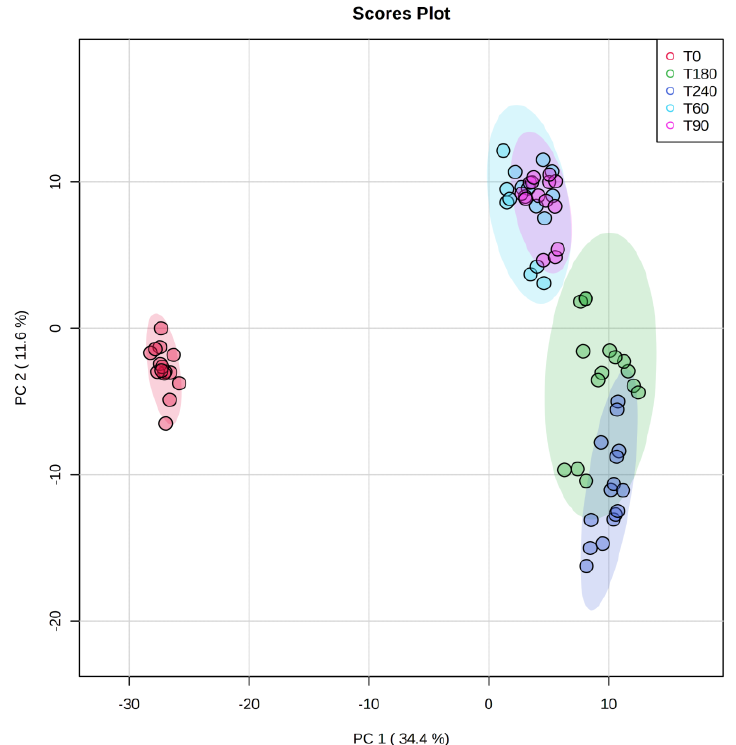
Figure 2. Score plot deriving from unsupervised principal component analysis of the untargeted metabolomic profile of Coppa Piacentina PDO samples during ripening time (i.e., T0, T60, T90, T180, and T240 days). Abbreviations: principal component 1 (PC1); principal component 2 (PC2).